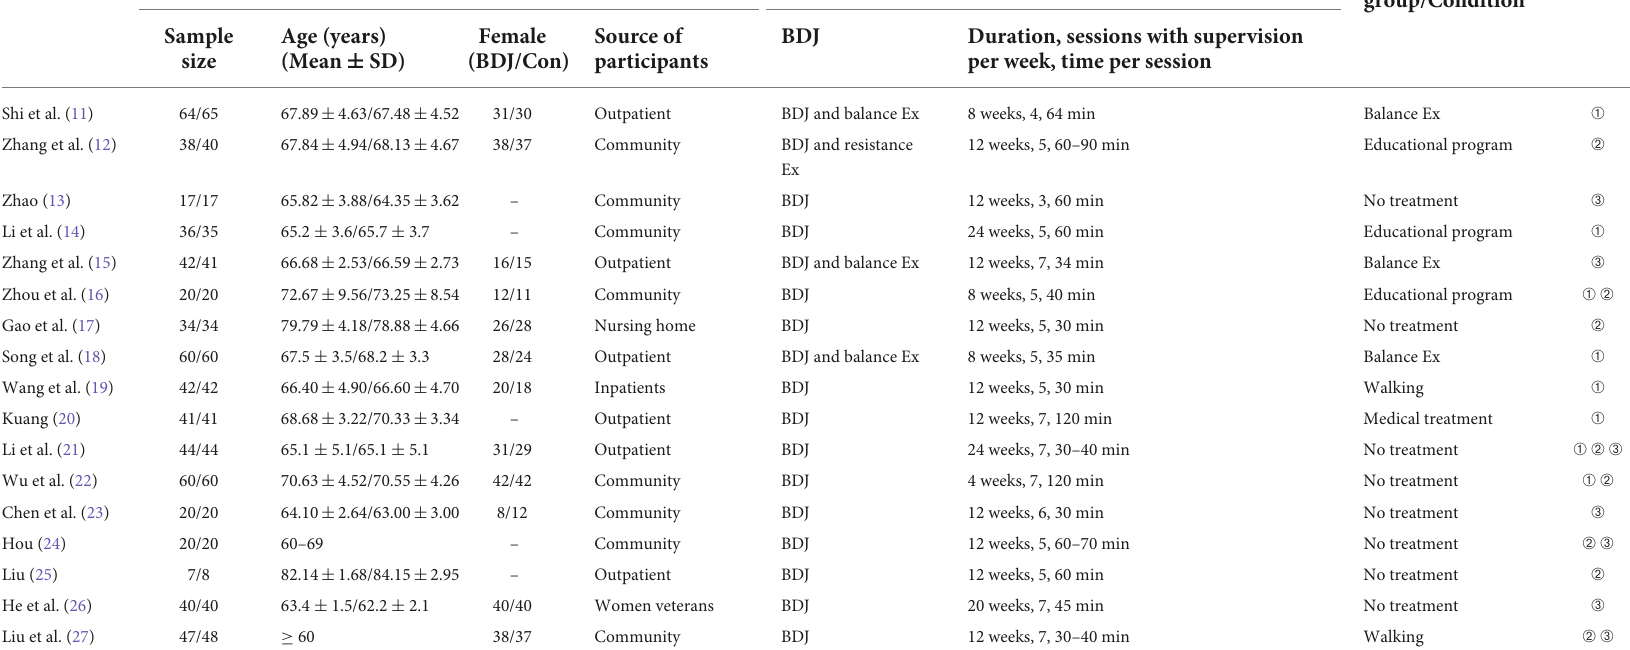
TABLE 1 Characteristics of the included